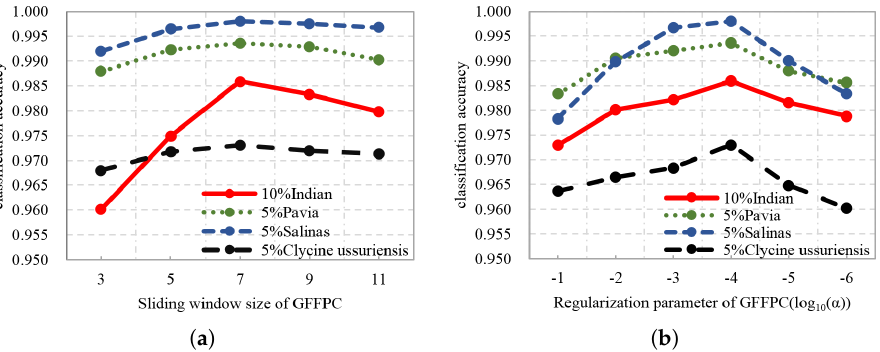
Figure 10. The impact on the classification results of different parameters of GFFPC ( a ) local sliding window size ω , ( b ) regularization parameter α .